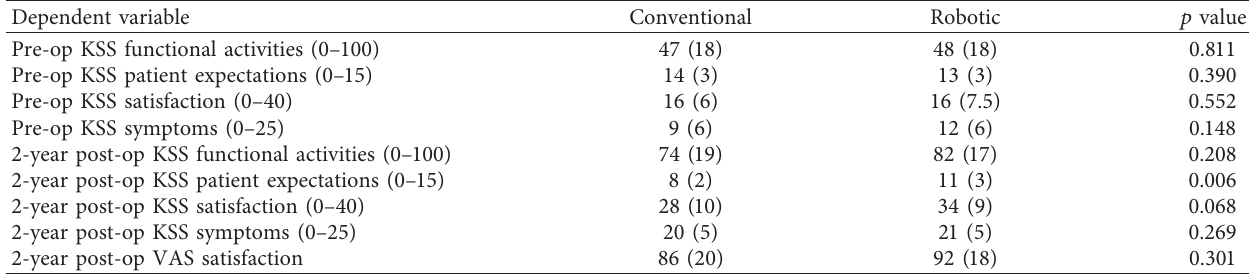
Table 3: A summary of preoperative, 2 year postoperative new Knee Society Scores, and 2 year postoperative VAS satisfaction scores. Dependent variable